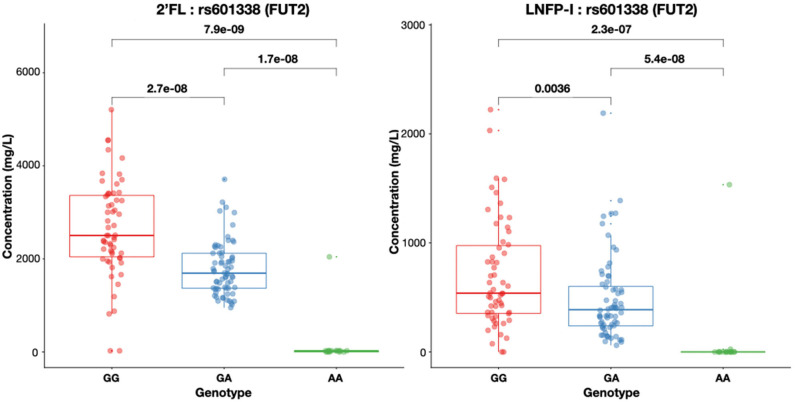
Both 2'FL and LNFP-I concentrations in mg/L in breast milk are significantly different (Mann–Whitney test for non-matched non-parametric data: P < 0.0001) depending on rs601338 genotypes. Box plots with median and 25 and 75% interquartiles and 95% CI are shown.